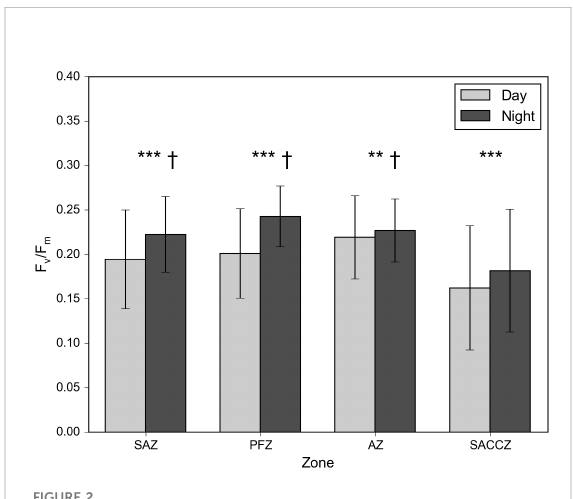
FIGURE 2 Diurnal variability of daytime and night-time means of F v /F m for all cruises grouped by zone. Error bars represent standard deviations. Signi fi cant differences are represented as *p<0.05, **p<0.01 and ***p<0.001, while † represents unequal variance where a Welch ’ s t-test was